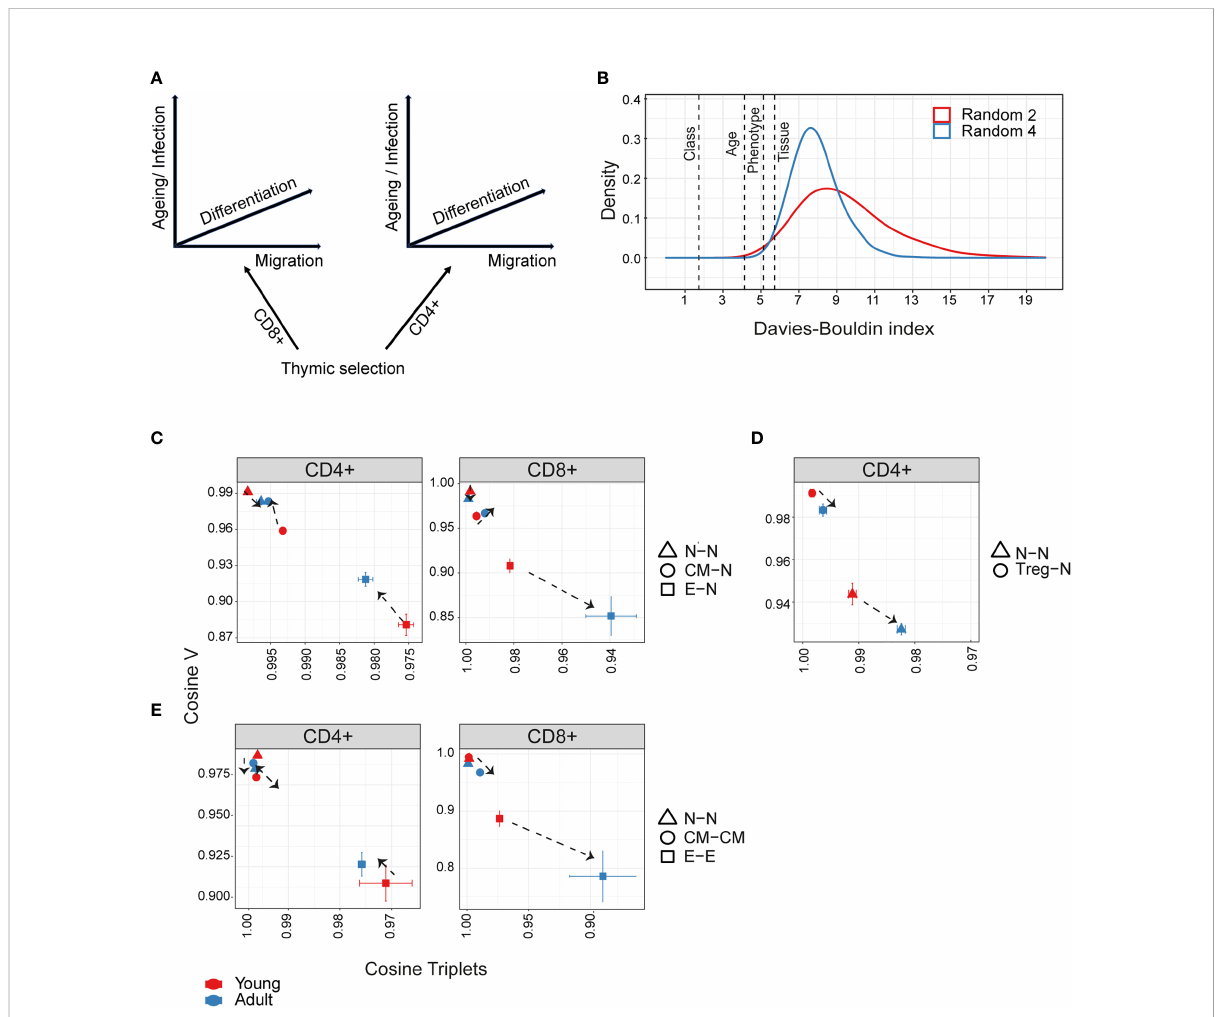
FIGURE 5 Hierarchical impact of different immunological processes on repertoire diversi fi cation. The TCR repertoire is considered as evolving in four dimensions, captured by the diagram in (A) . (B) The Davies-Bouldin (DB) index applied to V b frequencies, capturing the average separability (ratio of the within-cluster variance to the separation between cluster centroids (lower score means better clustering)) of clusters of different repertoires from their nearest counterpart. The reference distribution computed by assigning random clusters features (2 or 4 variables, red and blue lines respectively) to the same data and calculating the DB index 10000 times. (C – E) The mean inter-repertoire cosine similarity values of the V b gene distribution versus the mean inter-repertoire cosine similarity values for the 350 most abundant CDR3 b AA triplets. (C, D) Each repertoire (spleen only) is compared to the young naive repertoires for CD4+, CD8+ (C) and CD4+ Treg (D) . In E, each repertoire is compared to each other repertoire from the same compartment. The error bars represent SEM. Arrows show shift from young (red dots) to adult (blue